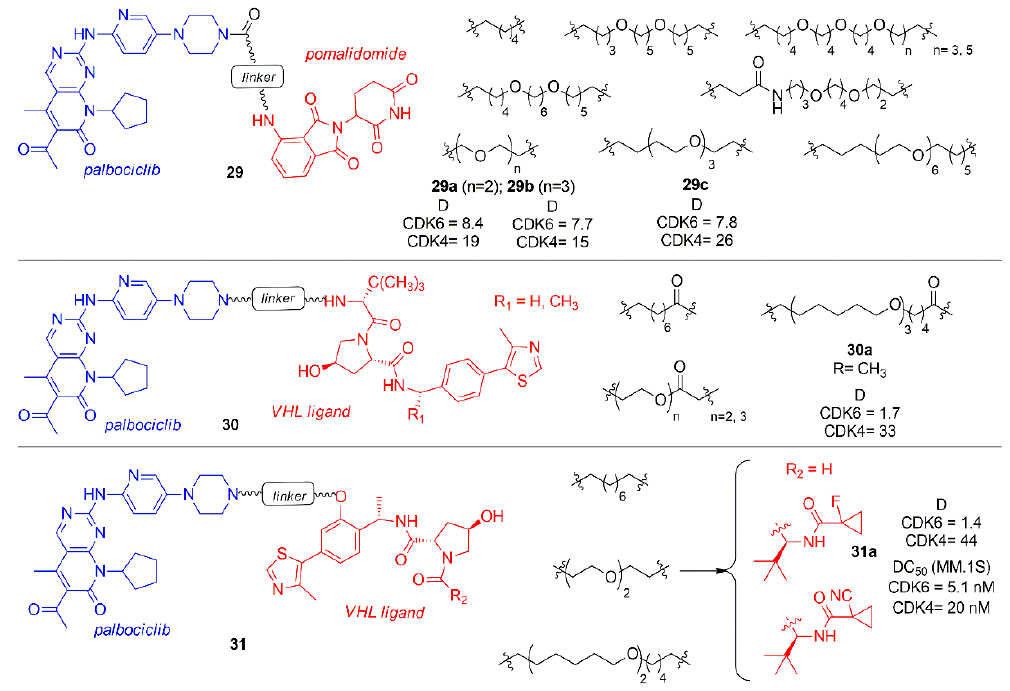
Figure 18. PROTACs containing palbociclib and E3 ligase ligand, such as pomalidomide and VHL ligand.